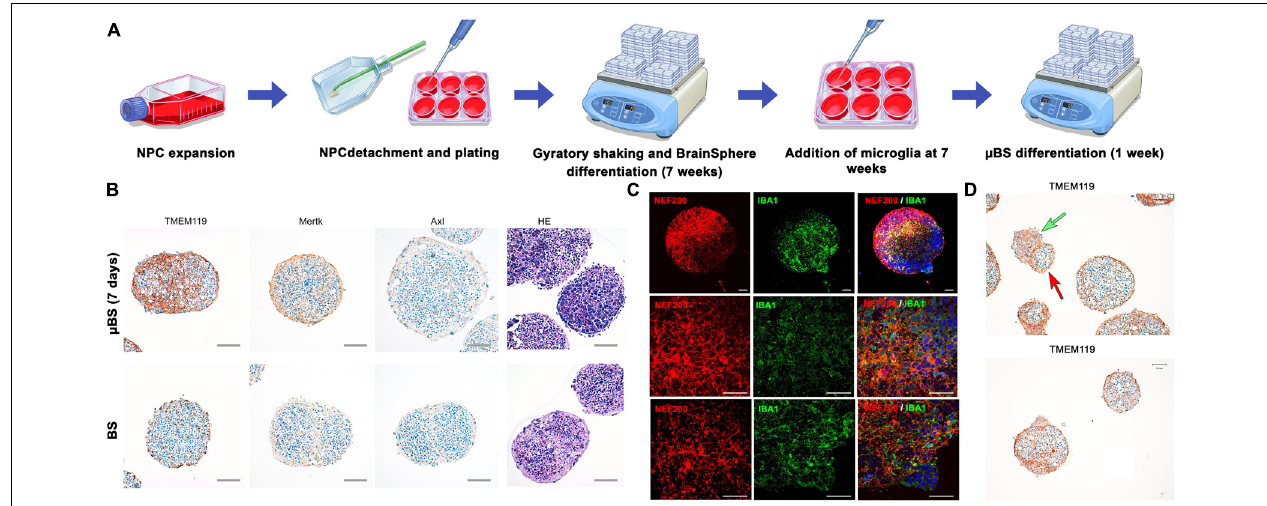
FIGURE 1 | Generation of microglia-containing BS ( µ BS). Immortalized Human Microglia – SV40 were incorporated to 7 week-differentiated BS by gravity as described in materials and methods. (A) Diagram of µ BS generation procedure. (B) Comparison between µ BS and BS using different microglia markers (TMEM119, Mertk, Axl) and hematoxylin/eosin (HE). (C) Confocal images of immunohistochemistry for the microglia marker IBA1 (green), the neuronal marker NF200 (red), and nuclear staining (Hoechst 33342, blue) in µ BS, 48 h after microglia incorporation. (D) Details of microglia aggregations in µ BS. Green arrow indicates microglia cluster and red arrow indicates the BS. Bars represent 100 µ m (B) , 50 µ m ( C , upper panel), 20 µ m ( C , all other panels), and 50 µ m (D)